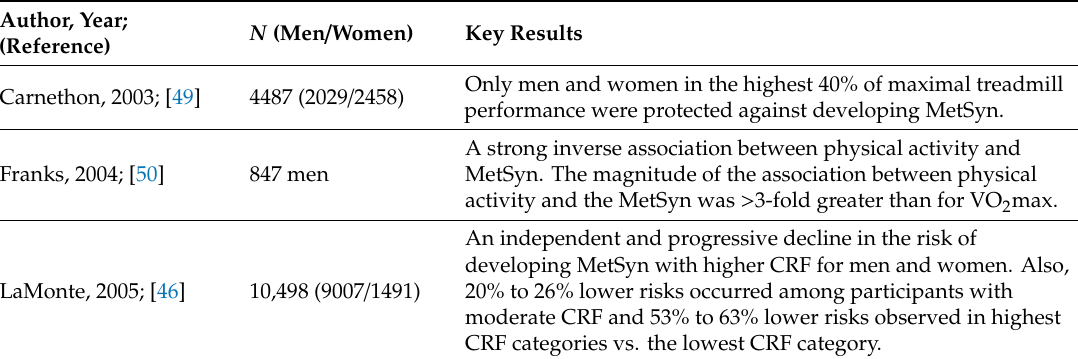
Table 2. Sampling of studies assessing the association between cardiorespiratory fitness and the metabolic